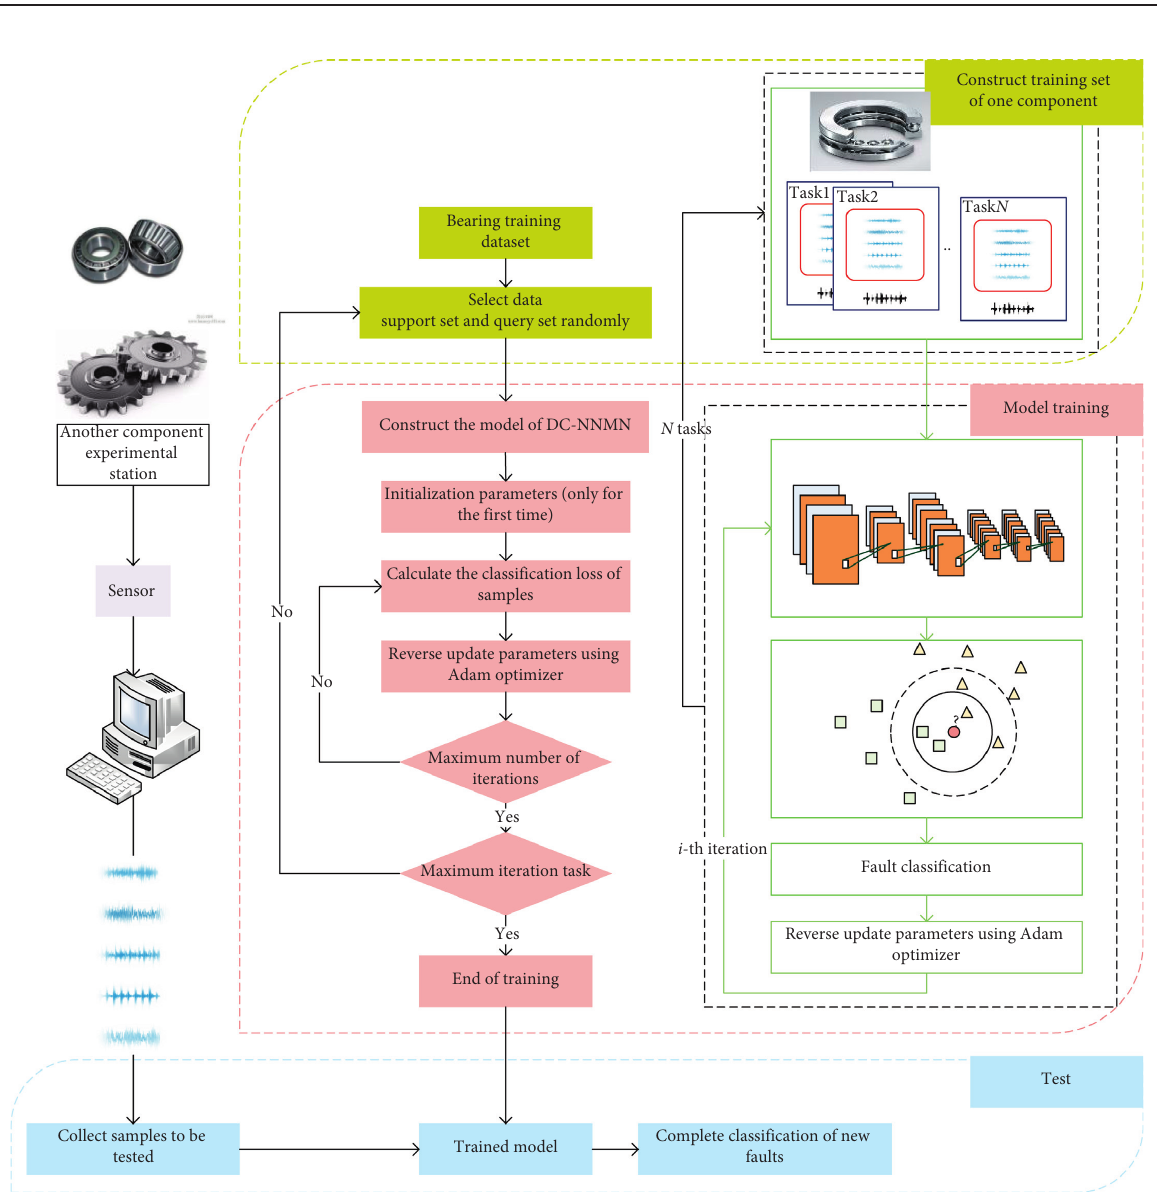
Figure 4: Flowchart of the proposed method.